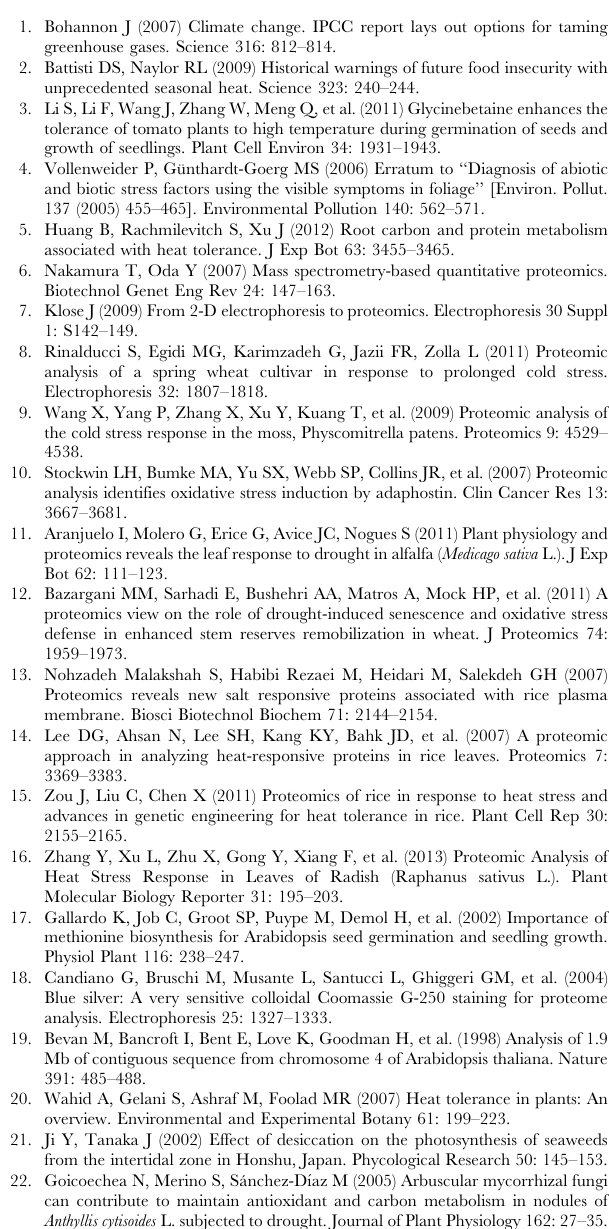
Table S1 Differentially expressed proteins identified by mass spectrometry between 24, 48 and 72 h heat stress (40 u C) and normal temperature (25 u C). Table S2 The homologs of unknown and hypothetical proteins identified by mass spectrometry between 24, 48 and 72 h heat stress (40 u C) and normal temperature (25 u